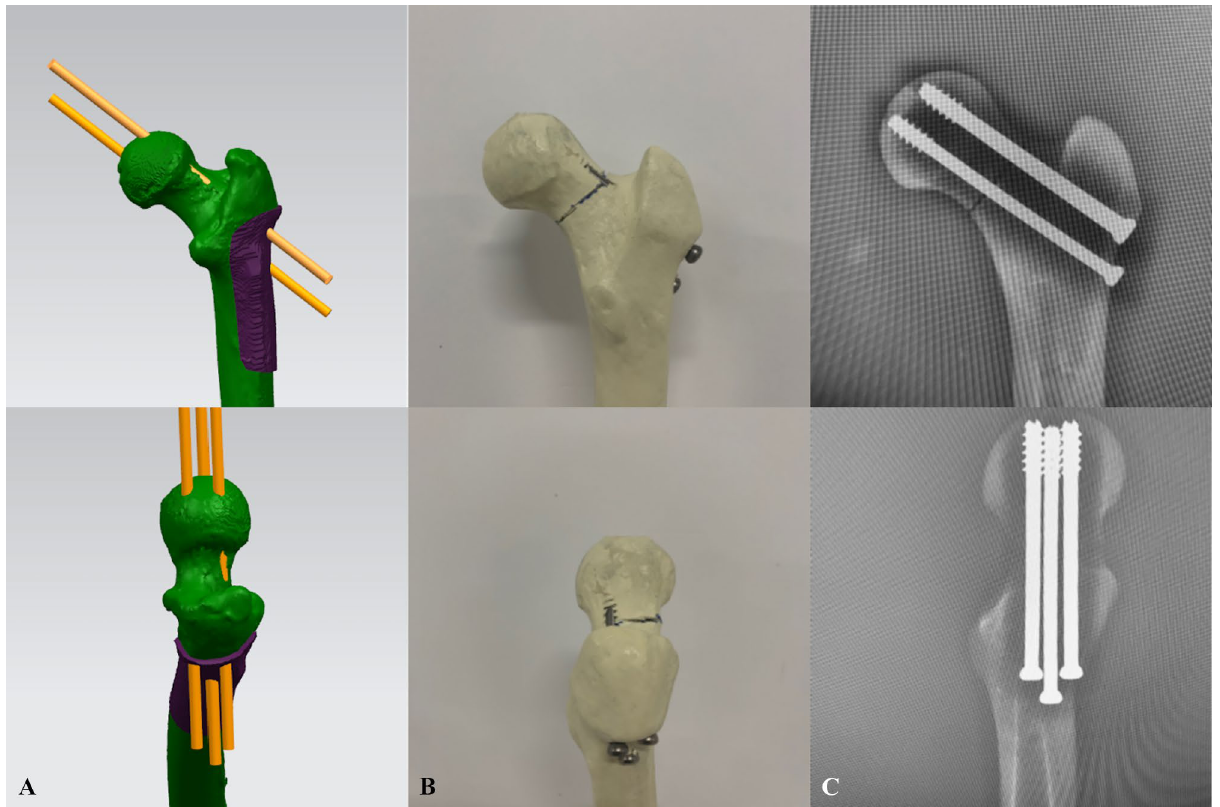
Figure 1. The limitations of the standard AP and lateral views in detecting IOI. ( A ) Software simulation IOI. ( B ) Specimen simulation IOI. ( C ) The standard femoral neck AP and lateral views showed all screws were contained within the femoral